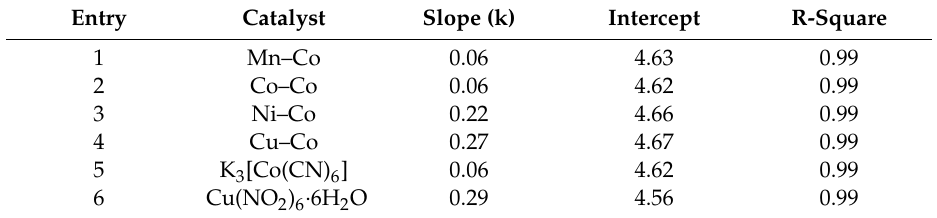
Table 4. Fitting parameters of the experimental points in Figure